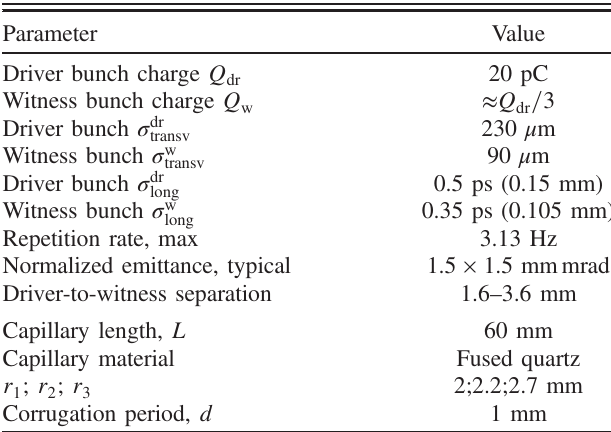
TABLE I. KEK: LUCX, beam parameters at rf gun section and capillary parameters.